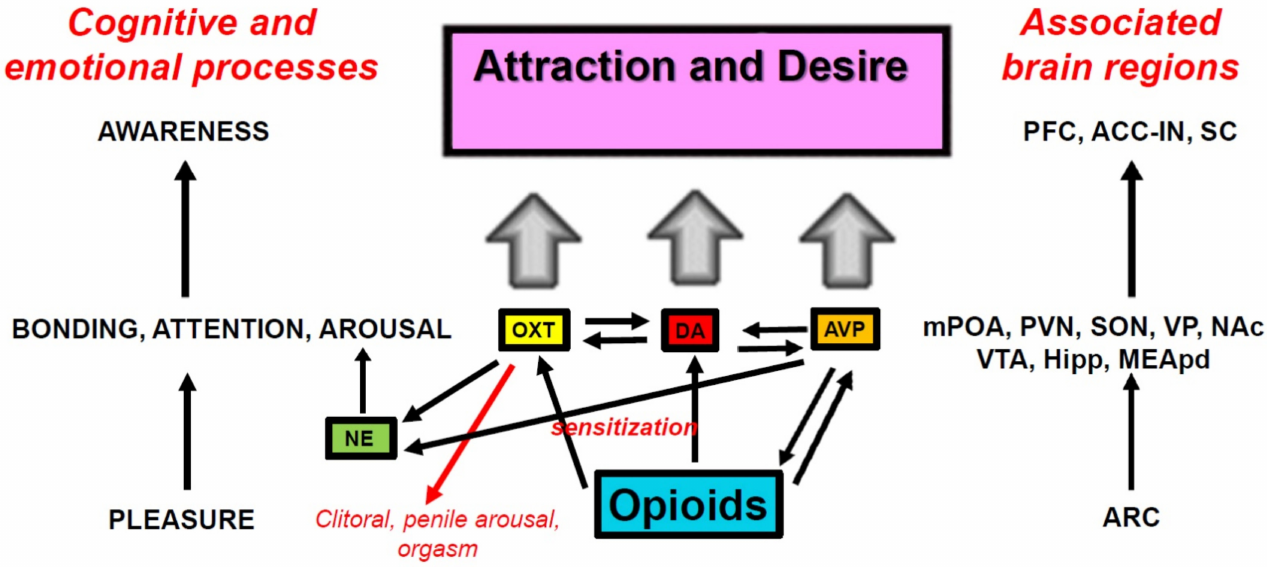
Figure 9. Mechanisms by which sexual pleasure and reward activate bonding, attention, and arousal to create motivation (desire) and attraction. Left: cognitive and emotional processes. Right: associated brain regions. ACC-IN = anterior cingulate-insula complex; ARC = arcuate nucleus; Hipp = hippocampus; NAc = nucleus accumbens (ventral striatum); MEApd = medial amygdala, posterior-dorsal region; mPOA = medial preoptic area; PFC = prefrontal cortex; PVN = paraven- tricular nucleus of the hypothalamus; SC = somatosensory cortex; SON = supraoptic nucleus of the hypothalamus; VP = ventral pallidum; VTA = ventral tegmental